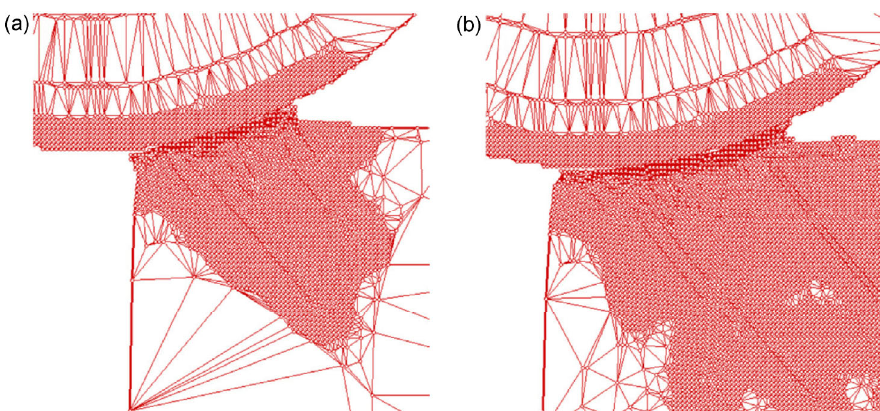
Fig. 8 Abrasive particles with radius of 20 nm at (a) 50 th time step, (b) 200 th time